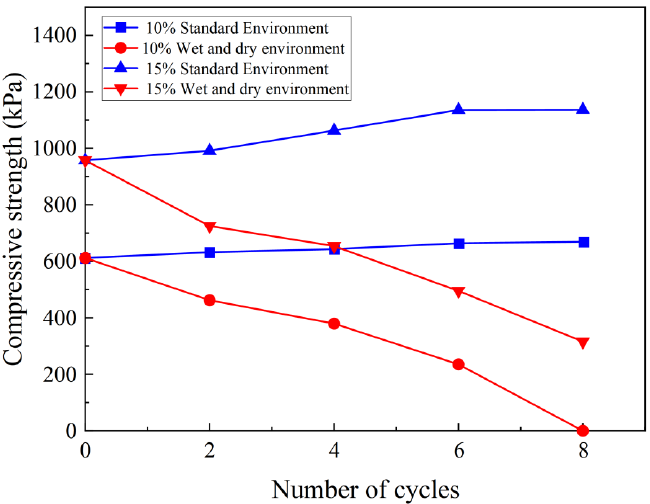
Figure 8. Variations in the compressive strengths of the samples with curing agent contents of 10% and 15% with an increasing number of wet–dry cycles.